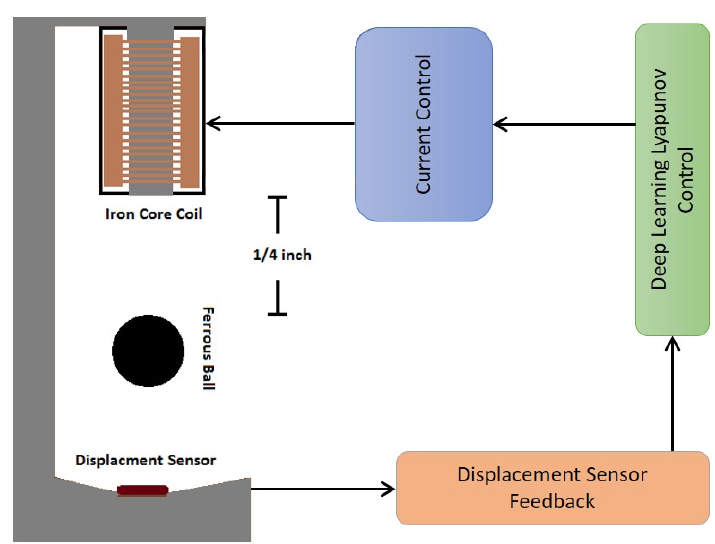
Figure 1. Magnetic levitation system controller